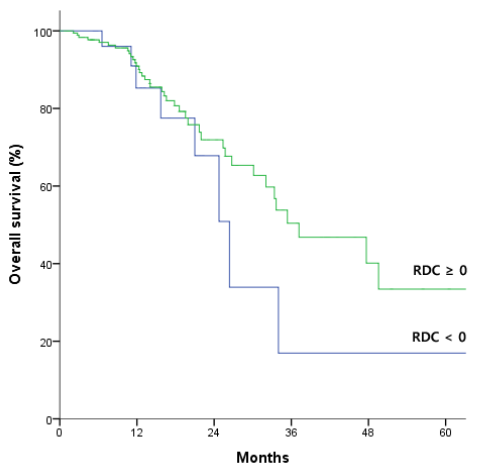
Figure 2. Kaplan-Meier analysis of overall survival in patients relative difference of carbohydrate antigen 19-9 (RDC) ≥ 0 and < 0. Median overall survival showed no significant difference between patients with RDC ≥ 0 and RDC < 0 (37.1 vs. 26.3 months; p = 0.293 by log-rank test). Table 2. Prognostic effects of carbohydrate antigen 19-9 concentration before neoadjuvant chemotherapy on overall survival and recurrence free survival.